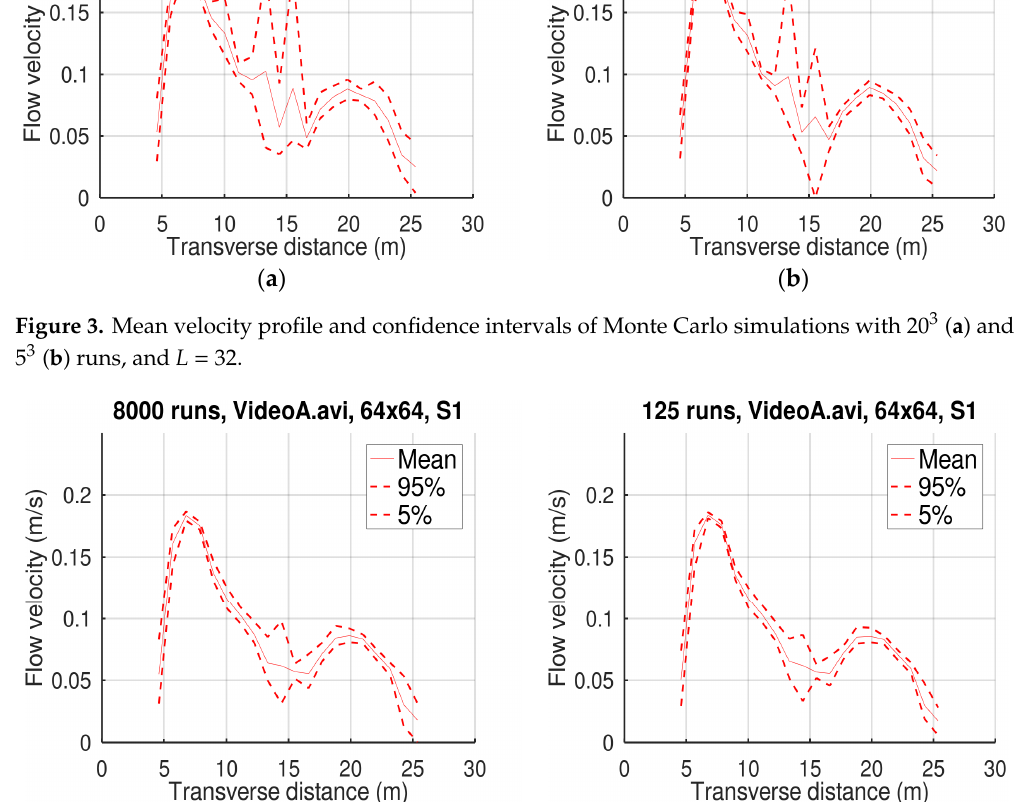
Figure 4. Mean velocity profile and confidence intervals of Monte Carlo simulations with 20 3 ( a ) and 5 3 ( b ) runs, and L = 64.